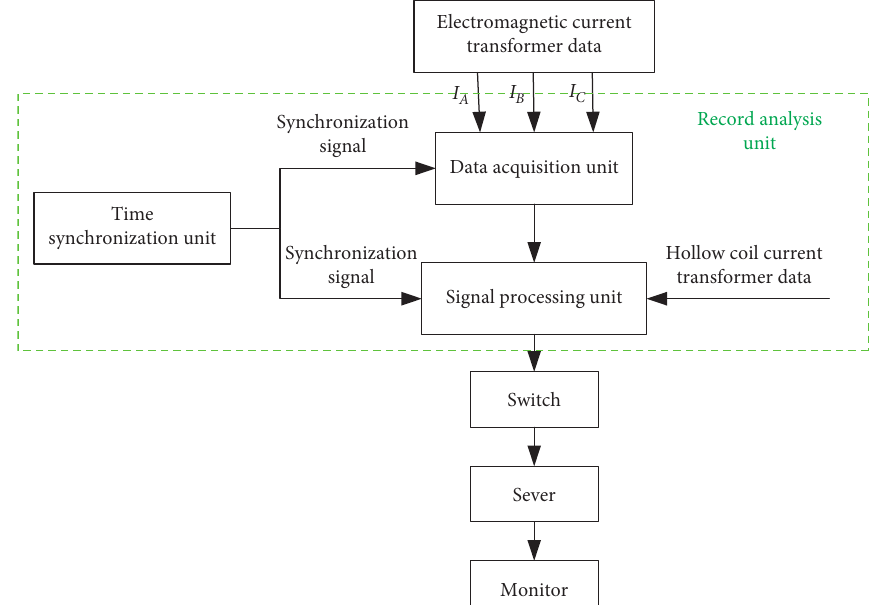
Figure 1: Block diagram of ET metering error condition monitoring platform.